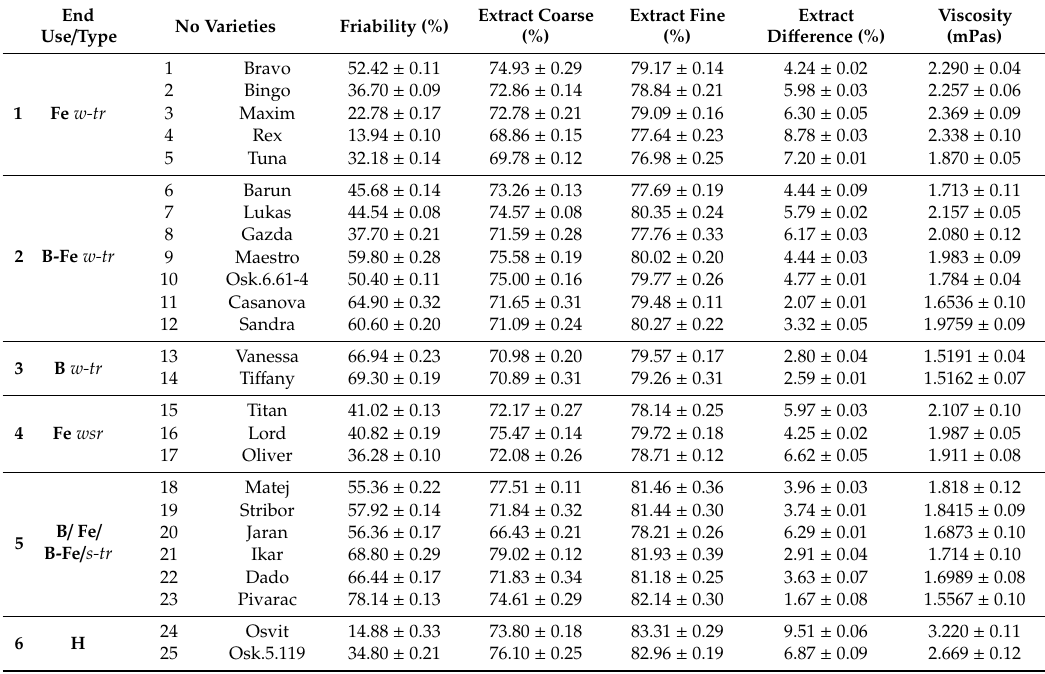
Table 5. Malt quality